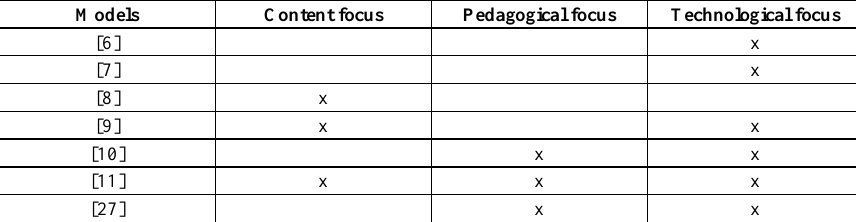
Table 1. ICT education models